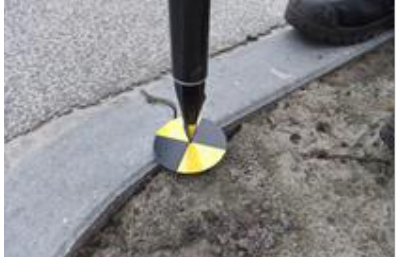
Figure-11: Result of bundle block adjustment by PhotoScan Professional for Nunspeet area.